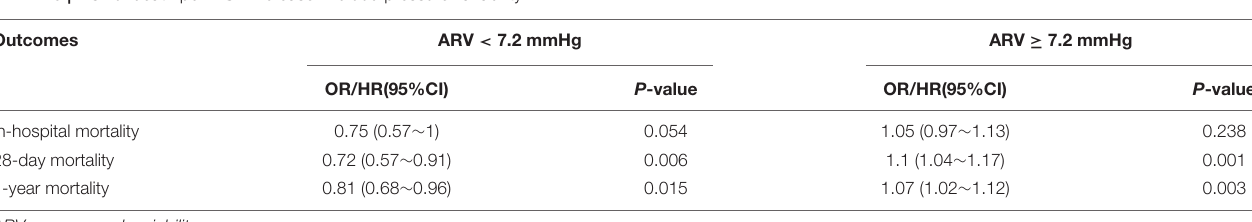
FIGURE 3 | Kaplan–Meier survival analysis plots for 28-day and 1-year mortality with MAP ARV. The curves show that patients with higher MAP ARV in the ICU had lower rates of 28-day survival (A) and 1-year survival (B) . ICU indicates intensive care unit; ARV, average real variability; MAP, mean arterial pressure. TABLE 3 | Risk of death per 1 SD increase in blood pressure variability.